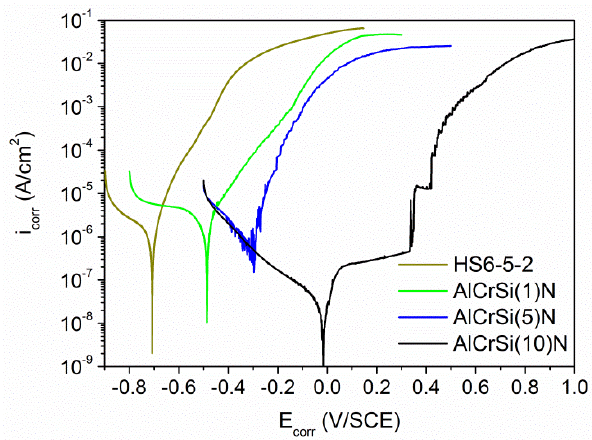
Figure 12. Results of the potentiodynamic polarization tests obtained for the HS6-5-2 and HS6-5-2 / AlCrSiN systems. Table 3. Electrochemical parameters estimated for the HS6-5-2 and HS6-5-2 / AlCrSiN